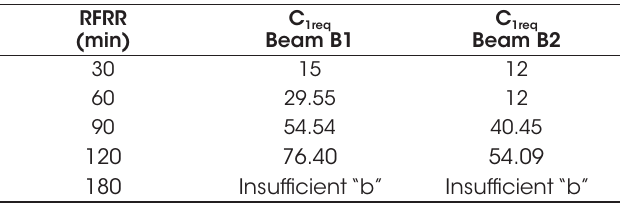
C1 coefficients required by NBR